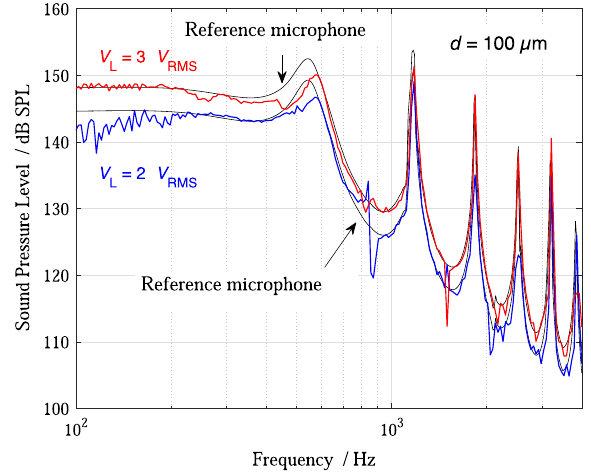
Figure 6. Sound Pressure Level measured with a microplasma microphone ( d = 100 l m) and a reference microphone for two voltages V L applied to the loudspeakers. Magnitude in dB SPL: 20 log( P mic / P ref ) with P ref = 20 (cid:4) 10 (cid:2) 6 Pa. Operating point of the discharge: U d ’ 680 V, I ’ 70 l A. Fitted sensitivities: S p2V ’ 0.46 (cid:4) 10 (cid:2) 9 A/Pa and S p3V ’ 0.5 10 (cid:2) 6